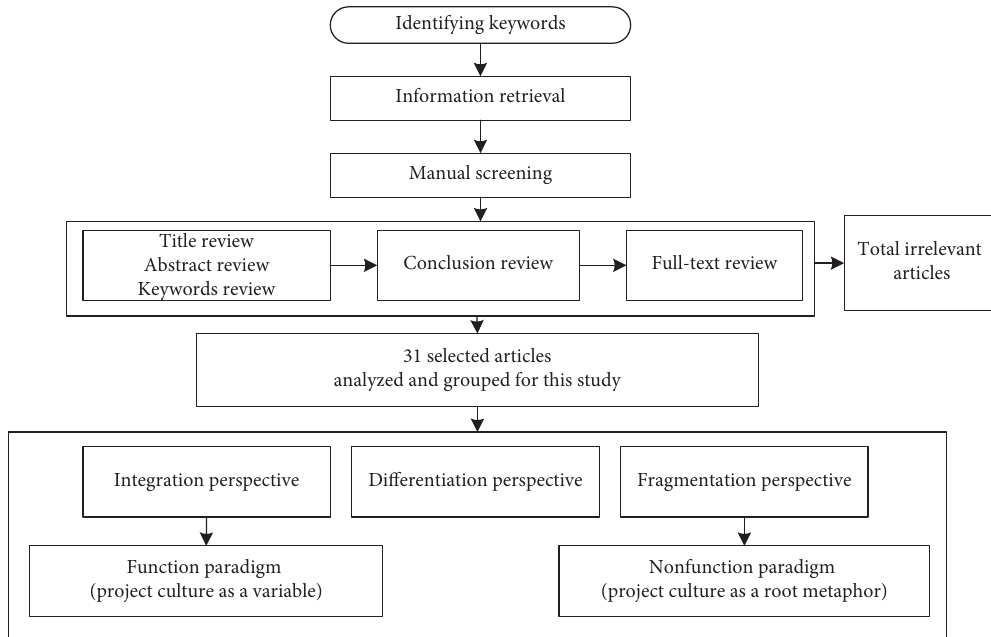
Figure 1: Overview of research